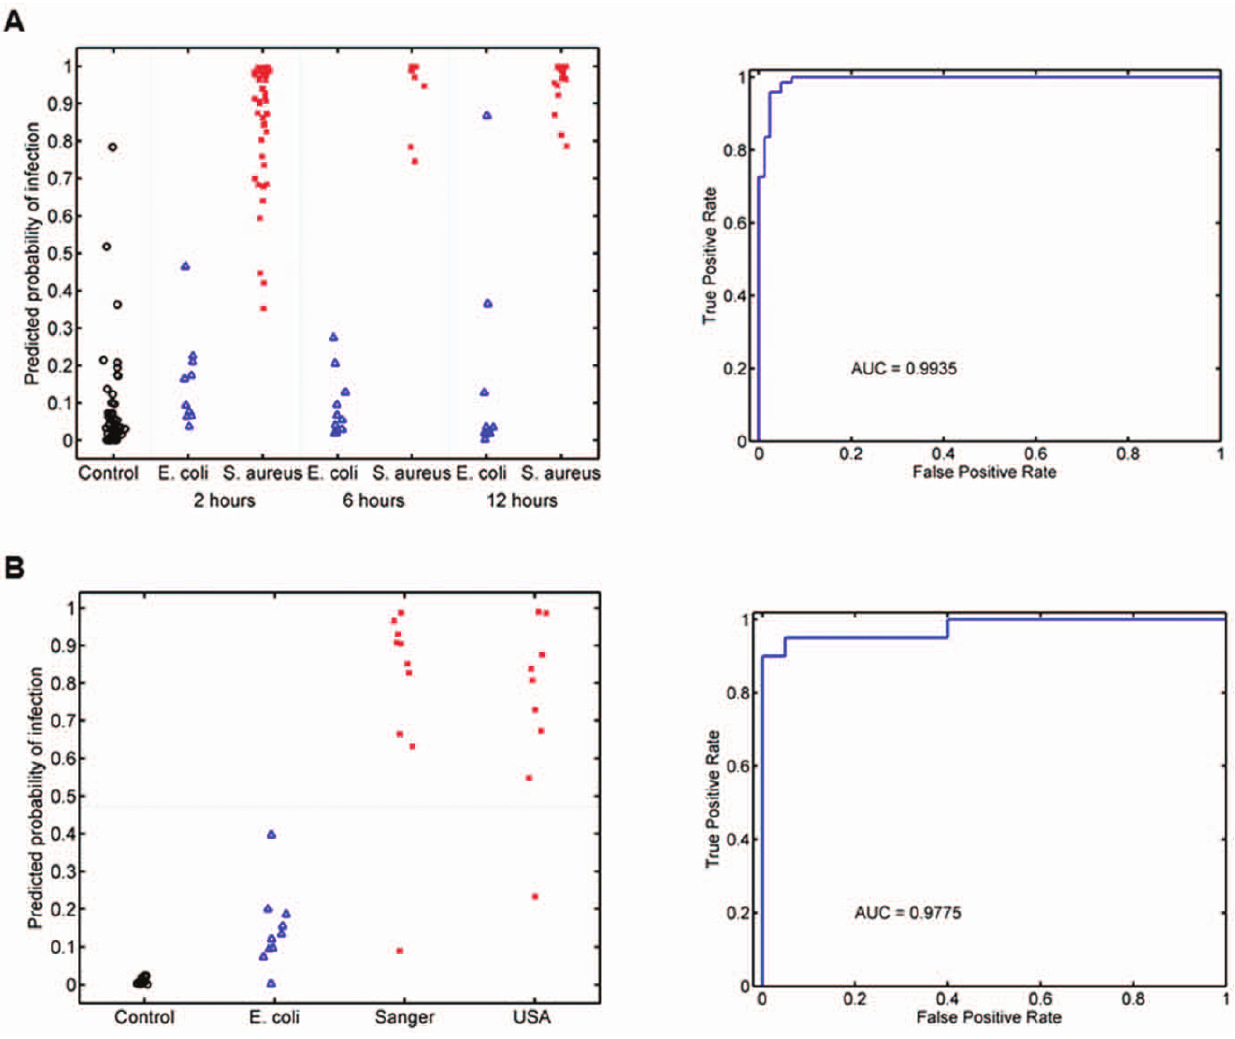
Figure 3. The murine S.aureus classifier differentiates S.aureus from E.coli infection. (A) Inbred mice were tested under three conditions: uninfected controls (black circles), S. aureus infected (red ‘‘x’’), and E. coli infected (blue triangles). The y-axis represents the predicted probability that a given animal was infected with S. aureus . (B) The murine S. aureus classifier is validated in outbred CD-1 mice where it differentiates S. aureus infection from E. coli infection and uninfected controls.